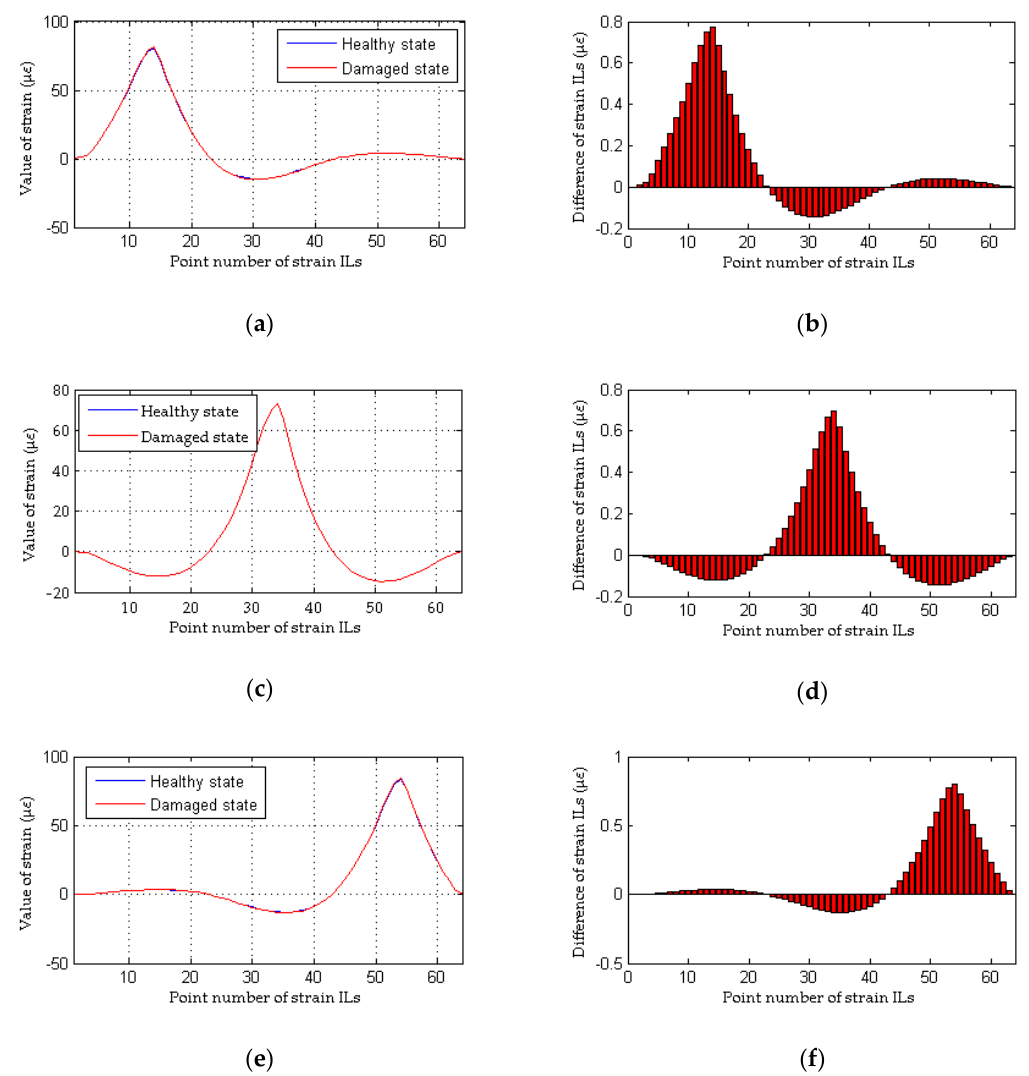
Figure 6. Results of the traditional method without the effects of measurement noise (for multiple damaged elements): ( a ) strain ILs at point #11 for case 1 and case 5; ( b ) difference in the strain ILs at point #11 before and after damage for case 5; ( c ) strain ILs at point #31 for case 1 and case 5; ( d ) difference in the strain ILs at point #31 before and after damage for case 5; ( e ) strain ILs at point #51 for case 1 and case 5; ( f ) difference in the strain ILs at point #51 before and after damage for case 5.